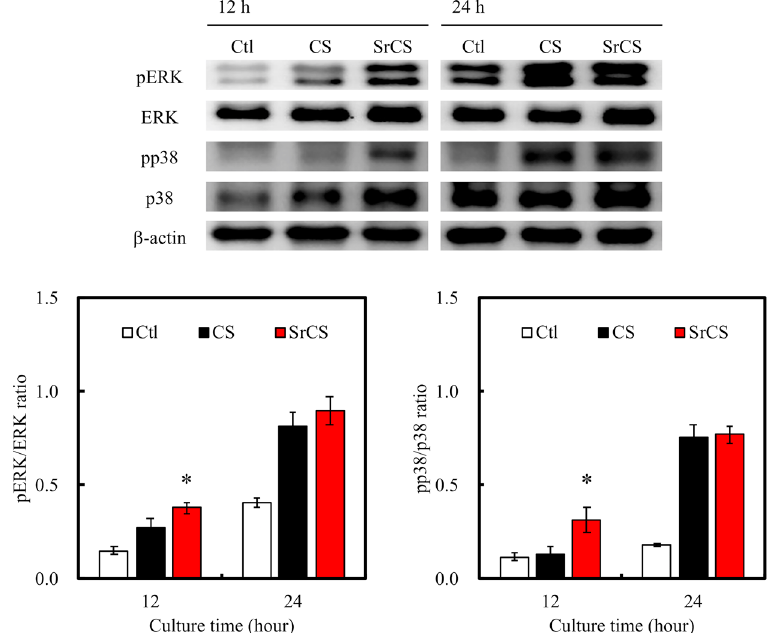
Figure 9. Western blotting of pERK, ERK, pp38 and p38 protein expressions of MSCs cultured on the various specimens for 12 and 24 h. “*” indicates a significant difference ( p < 0.05) when compared to CS scaffold. Data presented as mean ± SEM, n = 3 for each group. “Ctl” represented cells that grew in empty wells without any scaffolds.